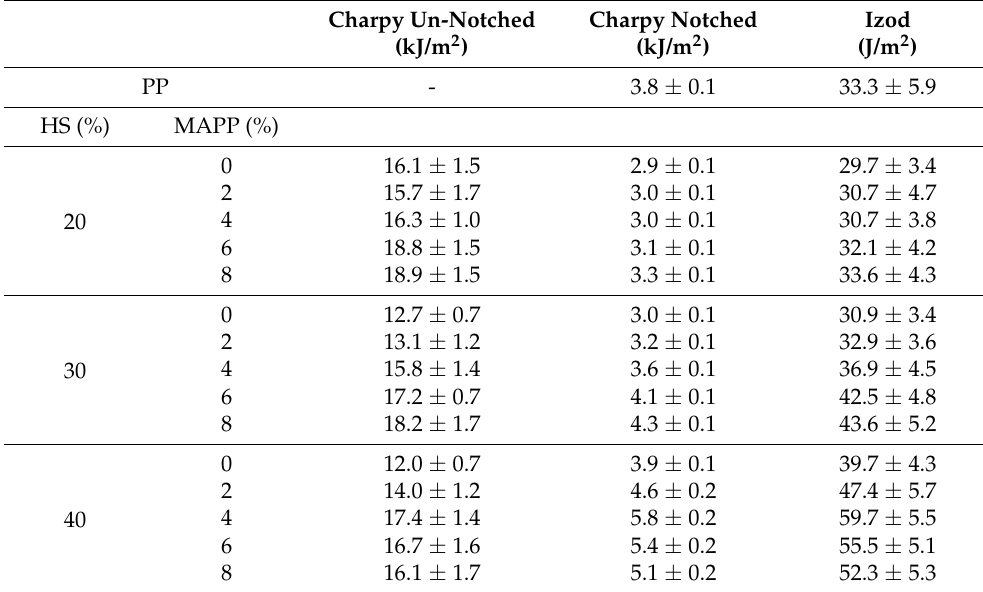
Table 1. Impact resilience of Charpy un-notched and notched, and Izod PP/HS composites against reinforcement and coupling agent contents (mean value ± standard deviation). Charpy Un-Notched Charpy (kJ/m 2 )